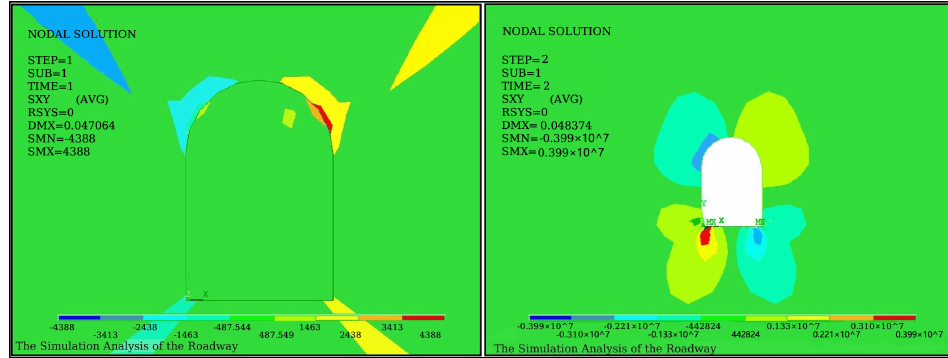
Figure 6. Diagram of shear stress fields before and after excavation.